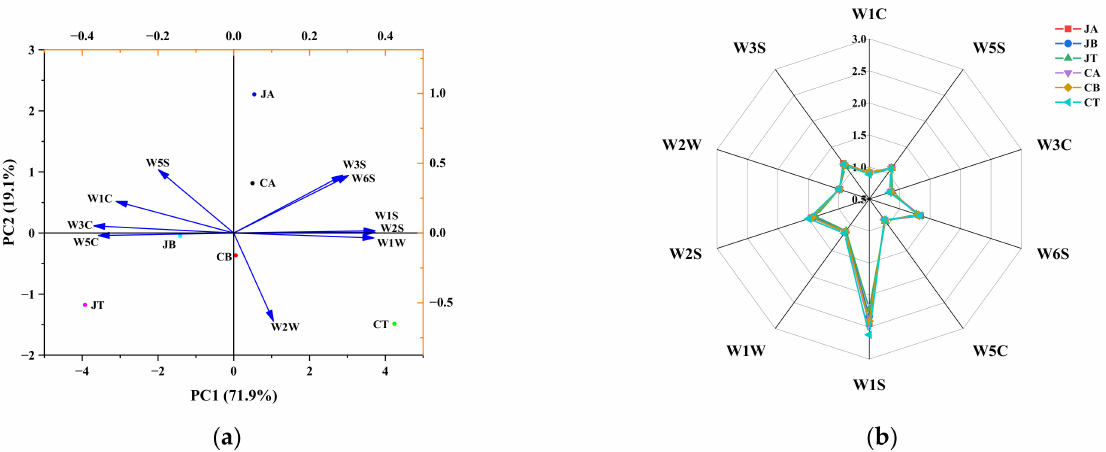
Figure 3. Principal component analysis (PCA) ( a ) and radar chart ( b ) of E-nose data for different parts of JPGC and CGC. JPGC: grass carp from Jingpo Lake; CGC: commercial grass carp; JA: abdomen of JPGC; JB: back of JPGC; JT: tail of JPGC; CA: abdomen of CGC; CB: back of CGC; CT: tail of CGC.